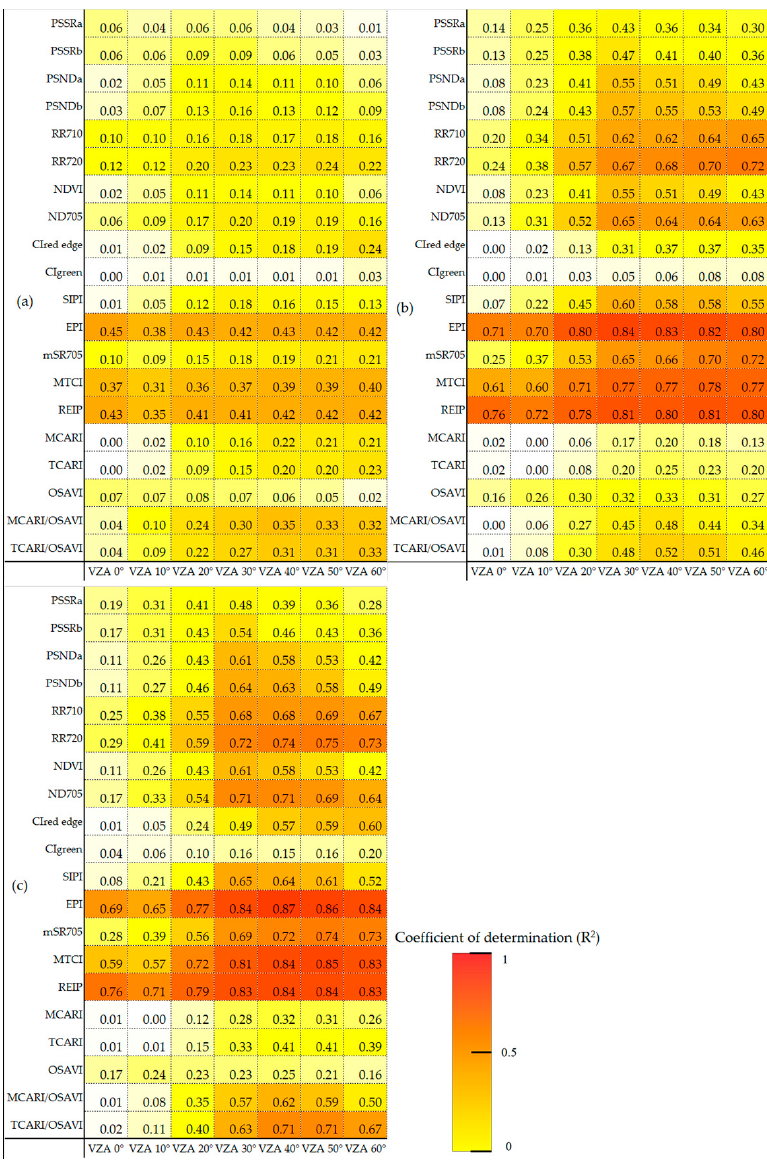
Figure 3. Coefficients of determination between the SPAD value in the early growth stage and the chlorophyll sensitivity index of different view zenith angles (VZAs): ( a ) 1st layer, ( b ) 2nd layer, and ( c ) 3rd layer.